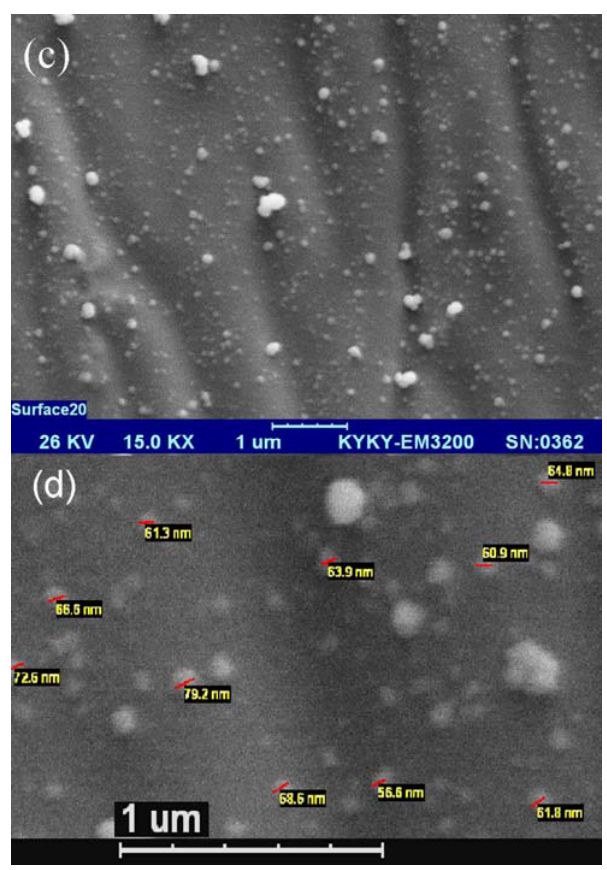
Fig. 5c-d. SEM images of starch/CuFe